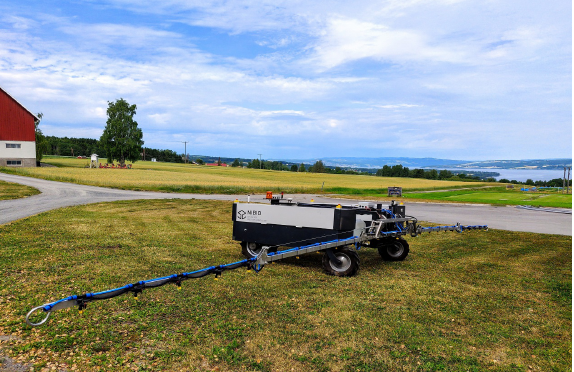
Figure 11. The AEV used in the experimental setup. It has a payload of a maximum of 750 kg. It is equipped with a three-point mount system similar to the one used by conventional tractors, which allows for a multi-purpose utilization. Eight 12 V batteries power the UGV. It has hydraulic actuators linked to the three-point hitch, that allow it to fold and unfold the fertilizer applicator arms that can be mounted on the back of the vehicle. The AEV runs on ROS, and can communicate via websockets with the